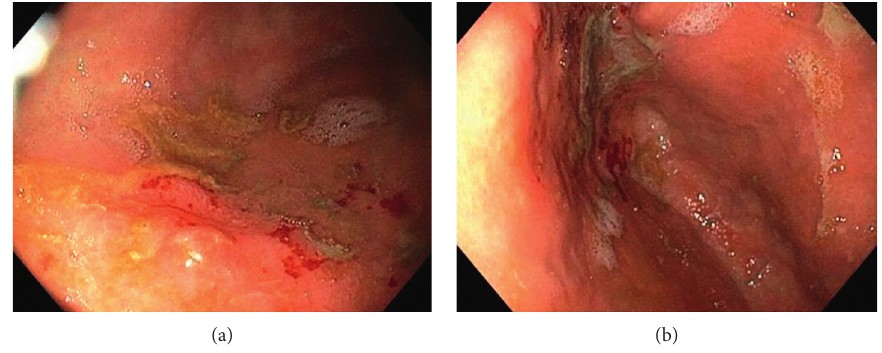
Figure 1: EGD consistent with severe, diffuse hemorrhagic gastritis.